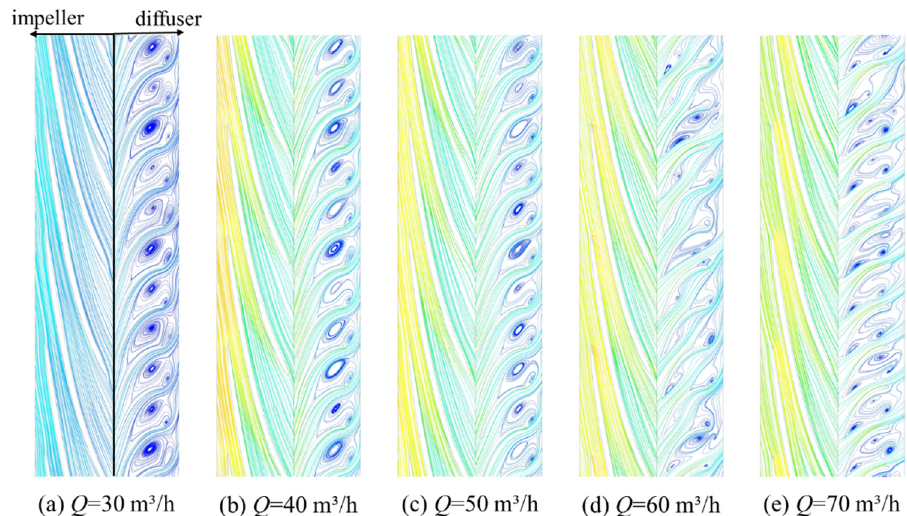
Figure 9. Streamline distribution in the impeller and diffuser at span = 0.5 for different flow rates ( Q = m 3 /h).